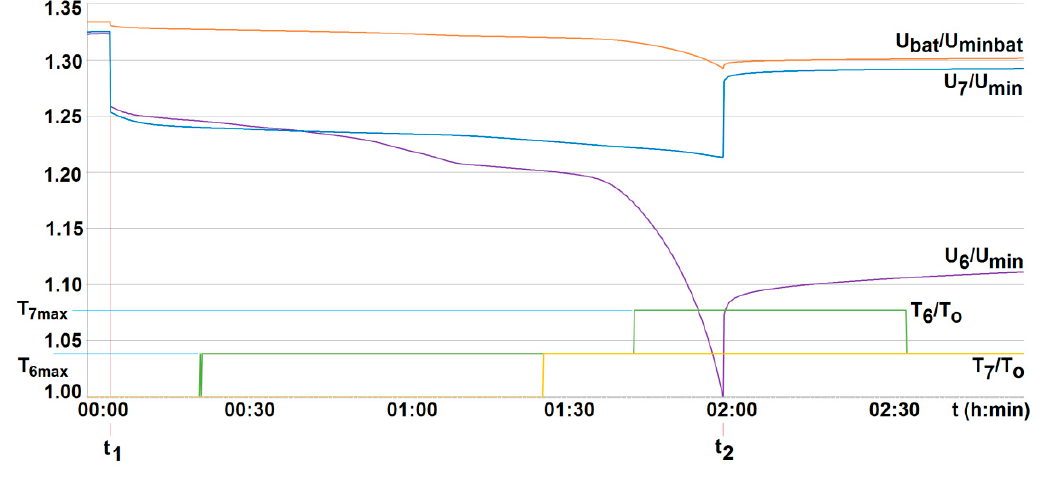
Figure 15. The voltage U 6 /U min and U 7 /U min and the temperature T 6 /T 0 , T 7 /T 0 variation with time for two series-loaded cells (cells no. 6 and no. 7—see Figure 14) of the unburdened battery without the BMS (room temperature T 0 = 20 °C, free cooling, t 1 , t 2 —moment of switching on and off the load current of 2.5 A with respective recharging, U min —minimum cell voltage equal to 2.5 A, U minbat —minimum battery voltage 20 V, U bat —battery voltage (maximum 29.2 V).